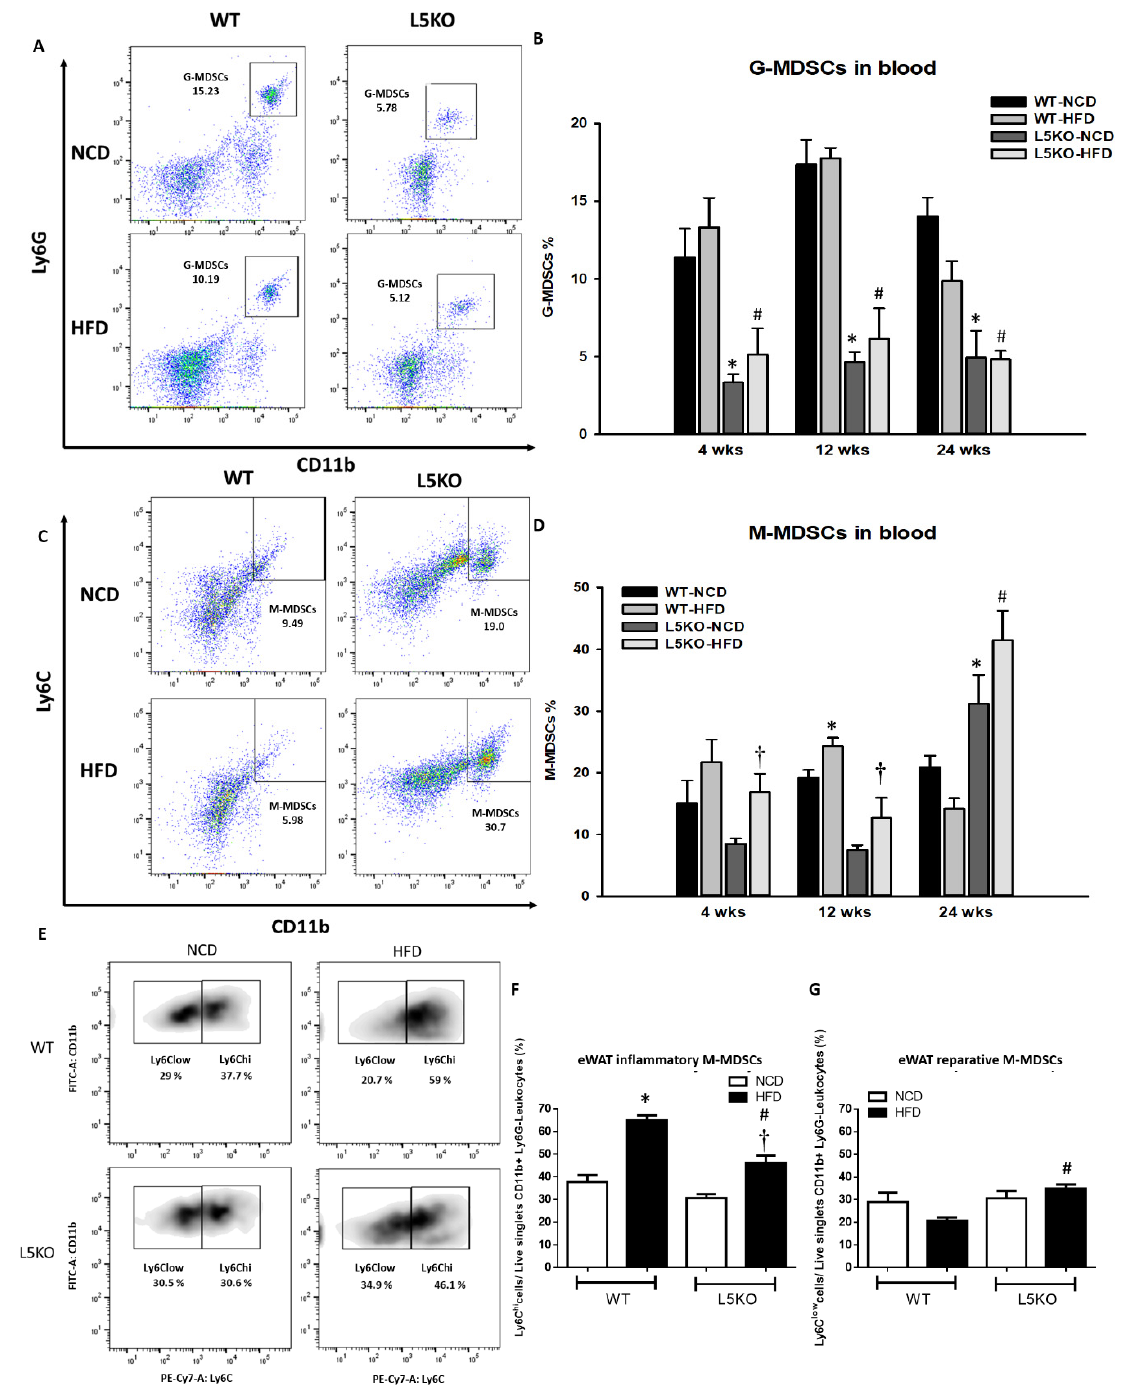
Figure 3. Recruitment of MDSCs into obesity-induced inflamed eWAT. Circulating ( A , B ) G-MDSCs and ( C , D ) M-MDSCs in WT and CCL5KO mice at 4, 12, and 24 weeks of age. Isolated SVF cells from eWAT were stained for CD11b, Ly6C, and Ly6G, and analyzed by flow cytometry. ( E , F ) The CD11b + Ly6G - Ly6C hi population represents pro-inflammatory M-MDSCs, and ( E , G ) the CD11b + Ly6G - Ly6C low subset represents reparative M-MDSCs in the SVCs of the eWAT via flow cytometry in WT and CCL5KO mice fed NCD and HFD diet for 18 weeks. Flow cytometric plots are representative of 12 mice/group of each group and data are presented as means ± SEM. Statistical difference is indicated: *, p < 0.05 vs. WT-NCD; #, p < 0.05 vs. WT-HFD; †, p < 0.05 vs. L5KO-NCD.